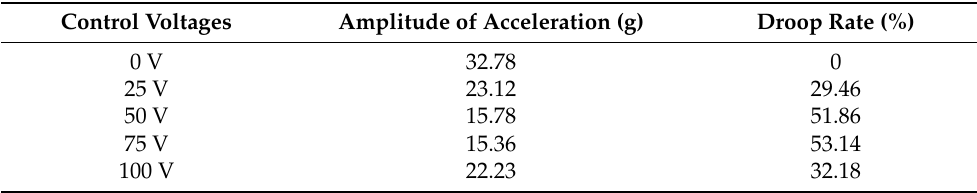
Table 6. The amplitude of acceleration response under different control